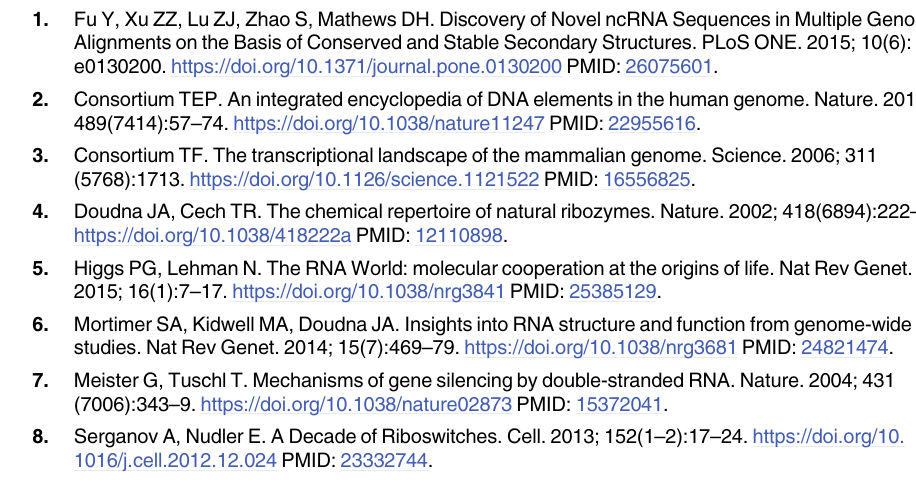
S1 Table. Comparison of RNA secondary structure prediction